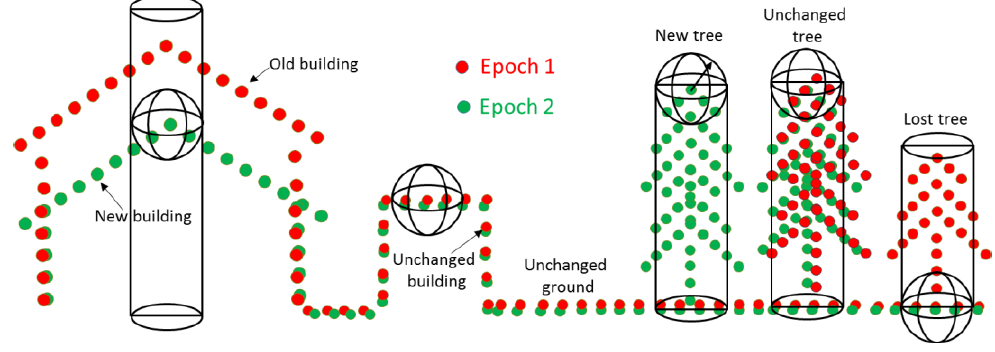
Figure 2. Stability of changed and unchanged objects.